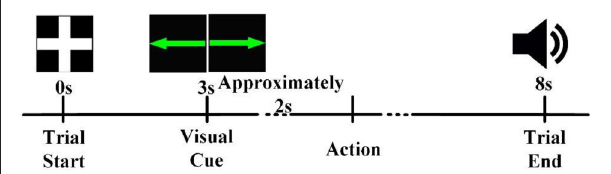
FIGURE 1 | The timeline of a trial. Each trial began in the idle state, in which the participant rested his or her hands, forearms, and elbows on the armrest of a chair and relaxed his or her hands. A visual cue informed the participant that a task should be performed about 2s later. After completion of the task, an auditory cue instructed the participant to return to the idle